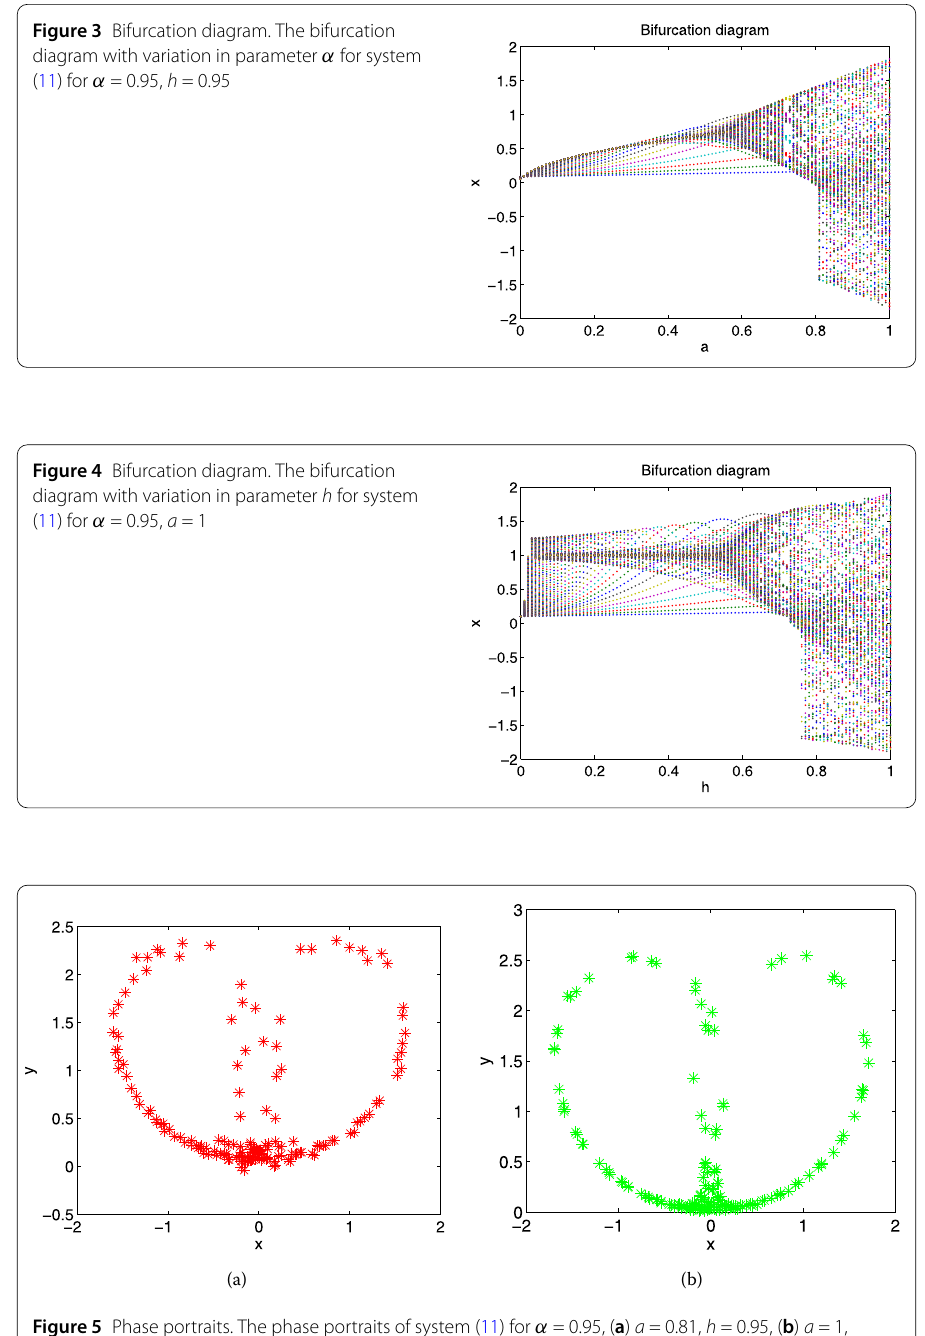
Consider a set of discrete data { φ ( n ), n = 0,1,2,..., N –1 } , and its corresponding